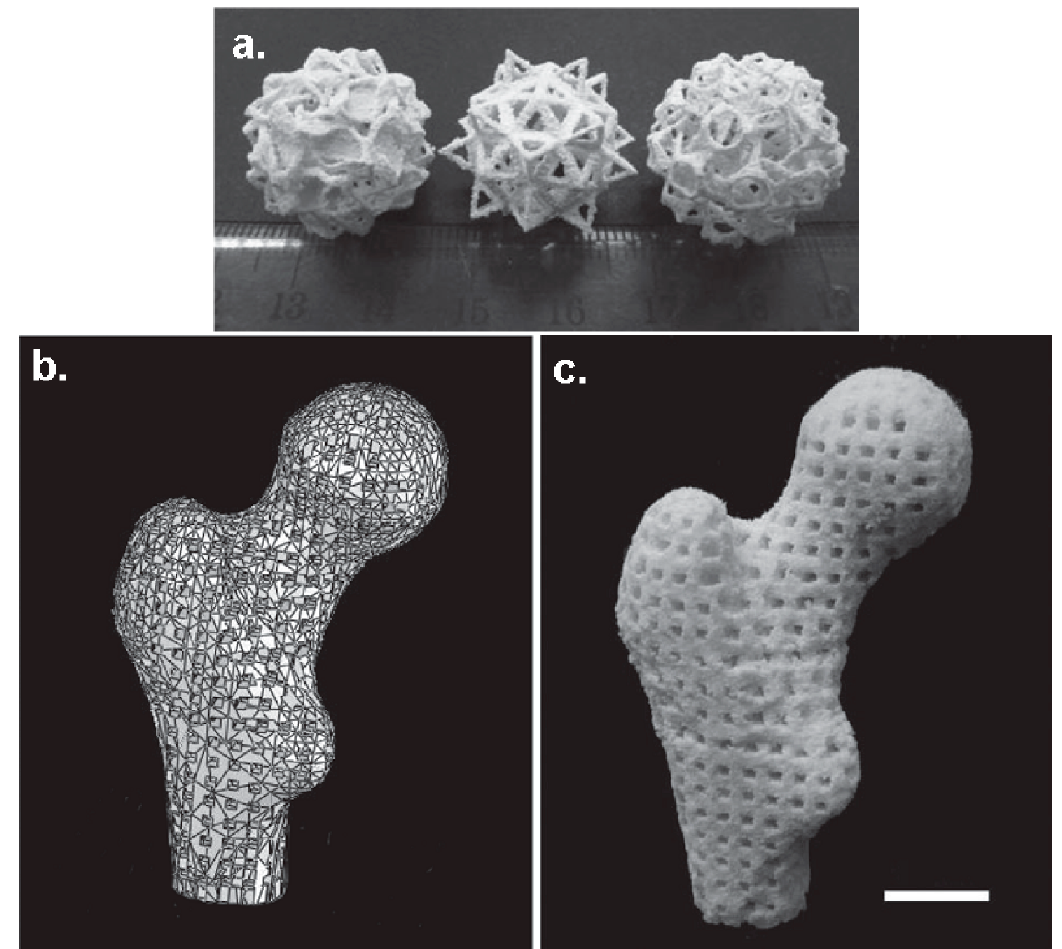
Figure 7. ( a ) Sintered Ca–P/PHBV nanocomposite porous structures based on the following models: salamanders, elevated icosidodecahedron and snarl (from left to right) ( b ) three-dimensional model of a human proximal femoral condyle reconstructed from CT images and then processed into porous scaffold using cubic cells; ( c ) sintered Ca–P/PHBV nanocomposite proximal femoral condyle scaffold. Scale bar, 1 cm. Reproduced with permission from [68].